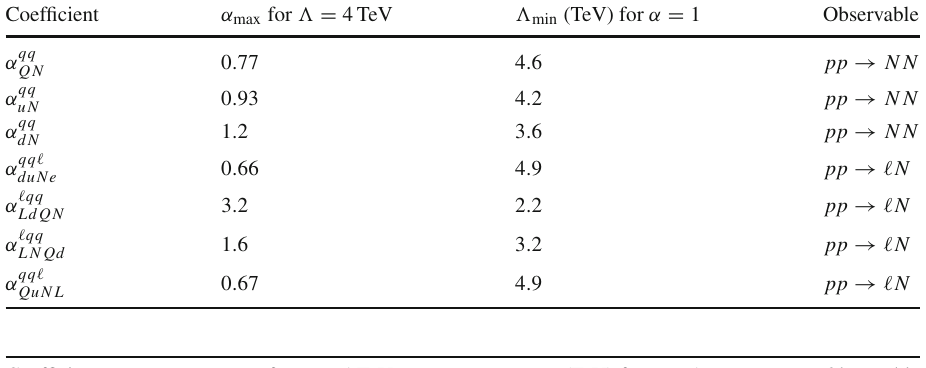
Table 10 Summary of limits on RRRR and LLRR operators and observables they result from, assuming m N = 0 . 1GeV